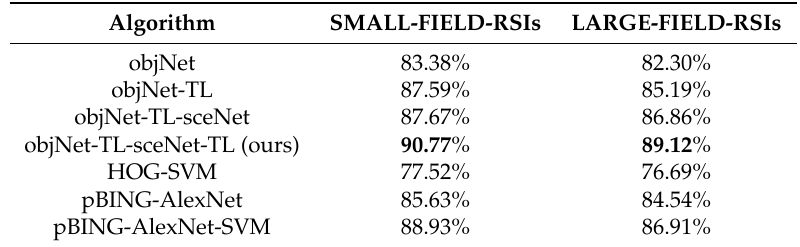
Figure 22. The performance comparison of different algorithms on the LARGE-FIELD-RSIs dataset. Table 8. The average detection accuracy (average precision